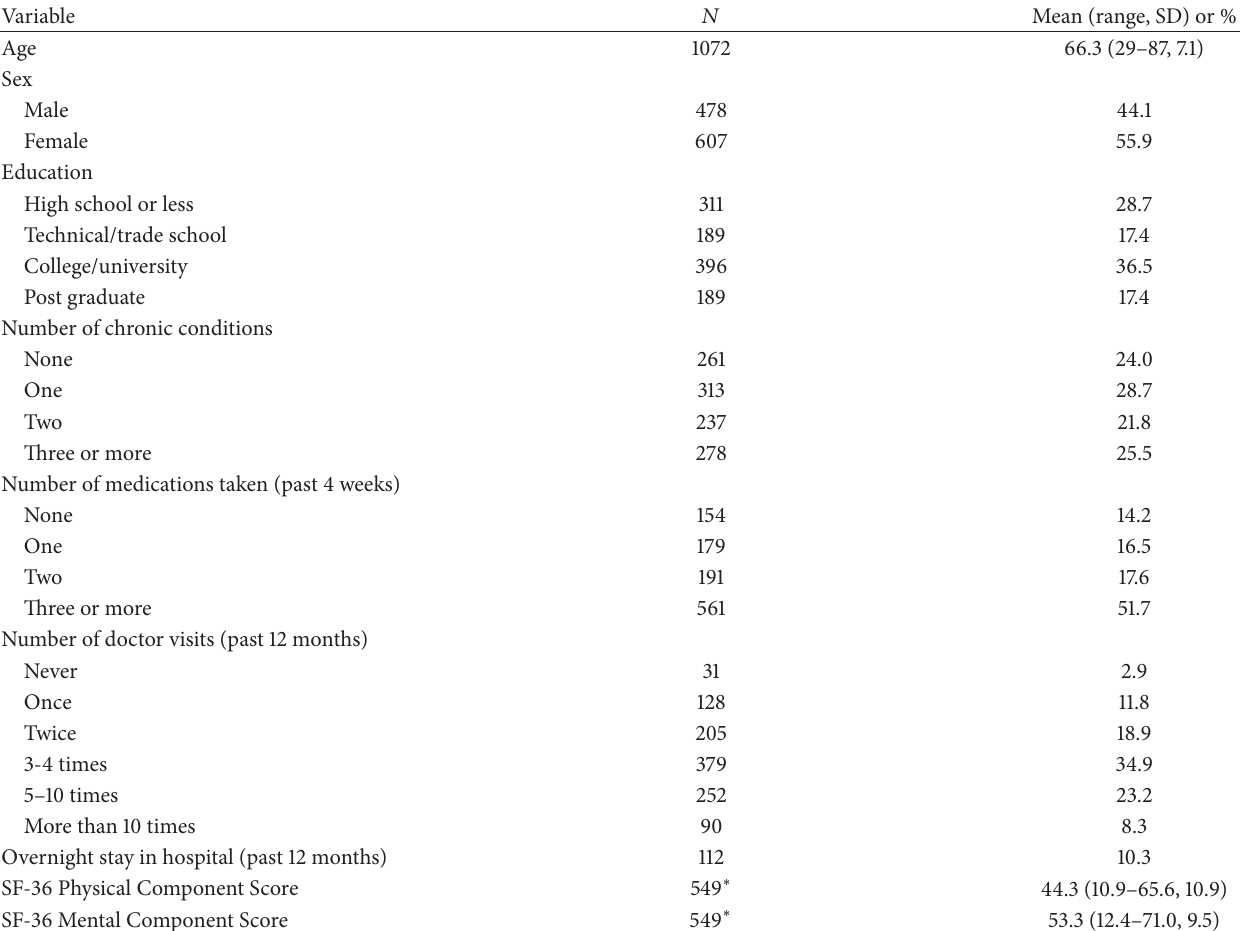
Table 1: Characteristics of the study